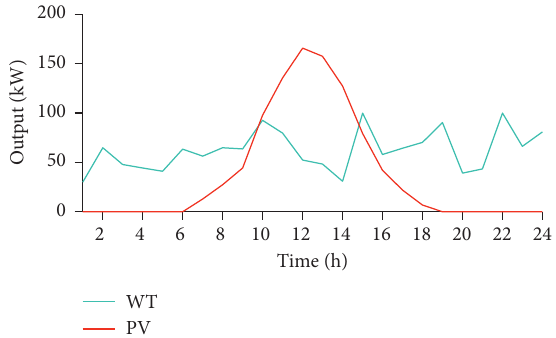
Figure 6: Output power of PV system and wind turbines.